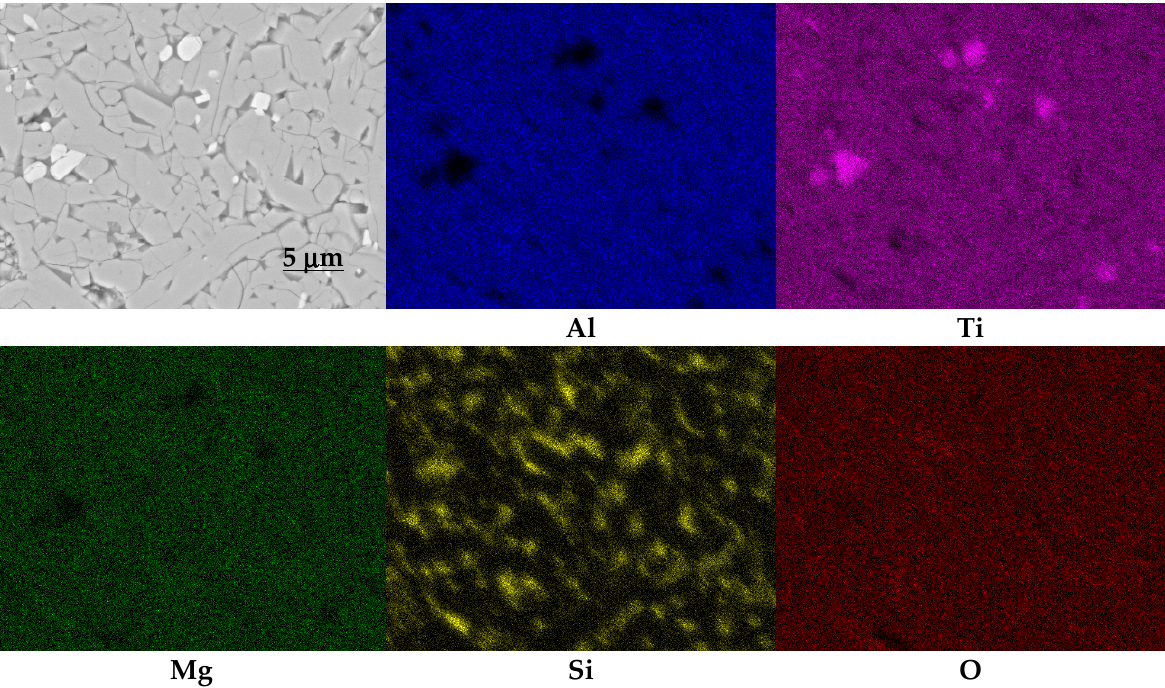
Figure 9. Maps of elemental distribution for sample AT 18MT 4S.